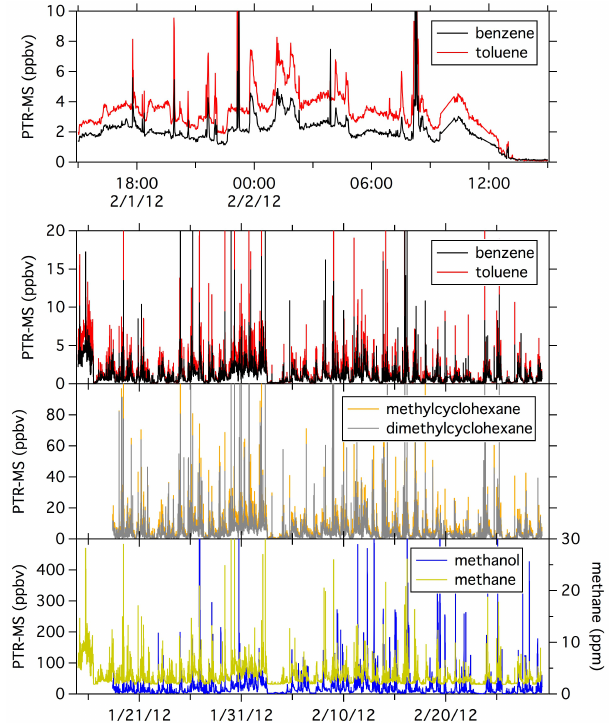
Figure 3. The time series of benzene and toluene for 1 day and various VOCs measured by PTR-MS and methane for the whole measurement period at the Horse Pool ground site during the UB- WOS2012 campaign. Maximum mixing ratios are off-scale.